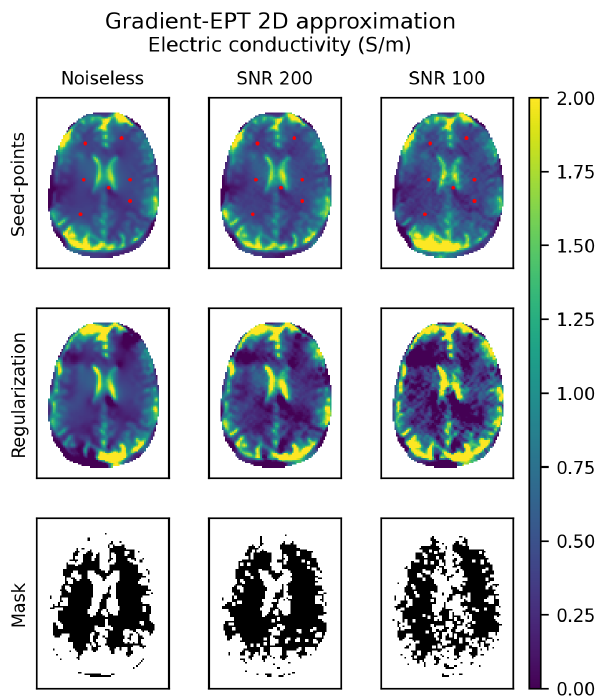
Figure 9. Electric conductivity distributions recovered by the two-dimensional approximation of gradient-EPT, to be compared with the actual distribution at 300MHz reported in Figure 8. All the distributions are recovered using a cross window of size [2,2,2] for the Savitzky–Golay filter. The seed points selected for the constraint are marked by red dots. The distributions recovered with regularization used a regularization coefficient λ = 1000. The masks adopted for regularization were obtained with a tolerance k = 0.02 in the noiseless case, k = 0.03 with SNR 200 and k = 0.05 with SNR 100. The resulting masks are reported. Results obtained with different amount of noise (noiseless, SNR = 200 and SNR = 100) were